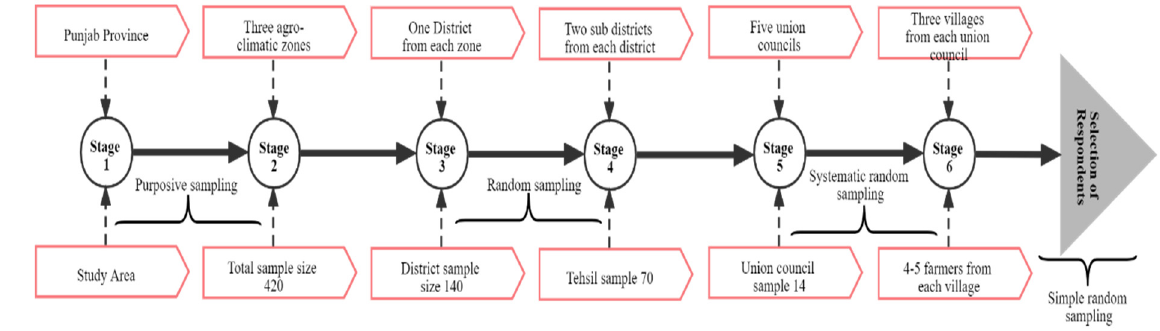
Figure 2. Sampling strategy.